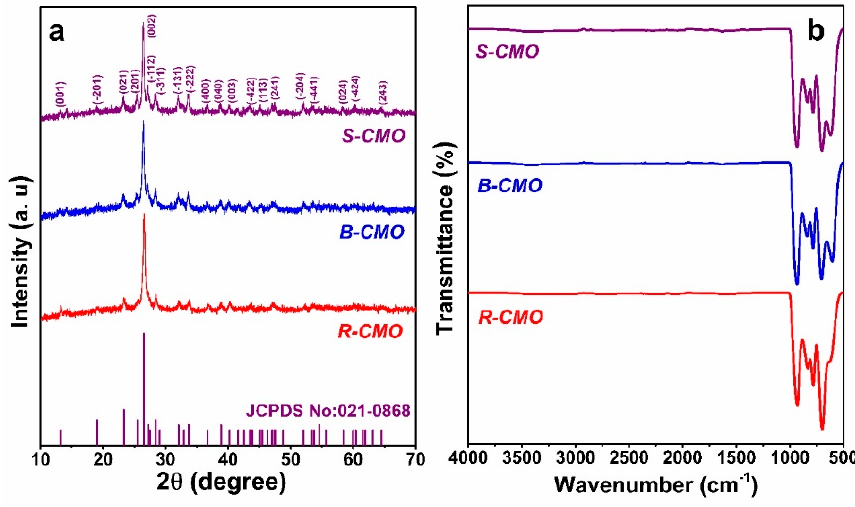
Figure 1. ( a ) XRD pattern and ( b ) FTIR spectra of synthesized CoMoO 4 nanostructured materials. In addition, using the following equations (Equations (1) and (2)) the crystallite sizes ( D ) of the nanostructured materials are determined to be 84.62, 97.16, and 148.09 nm and the cell volumes ( v ) are 635.51, 637.53, and 644.01 ˚A 3 , corresponding to R-CMO, B-CMO, and S-CMO, respectively [35,36].